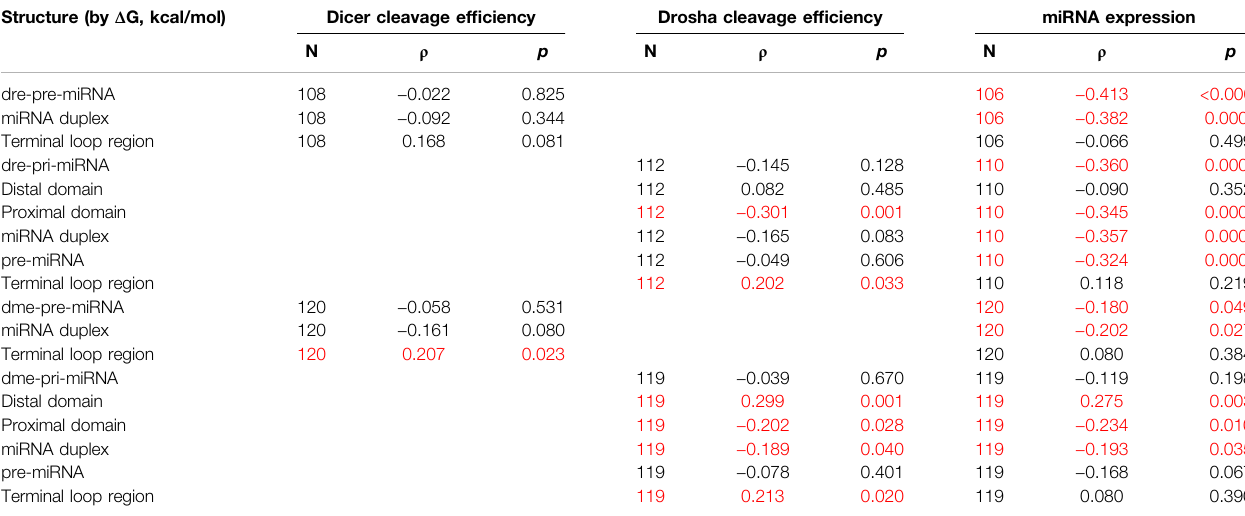
TABLE 2 | Correlation between predicted RNA structures and miRNA cleavage or miRNA expression. Sample size (N), Spearman ’ s correlation coef fi cient ( ρ ), and p values are listed. Correlations with p < 0.05 are marked in red. Raw data are in Supplementary Tables S1 – S4 . Structure (by Δ G,